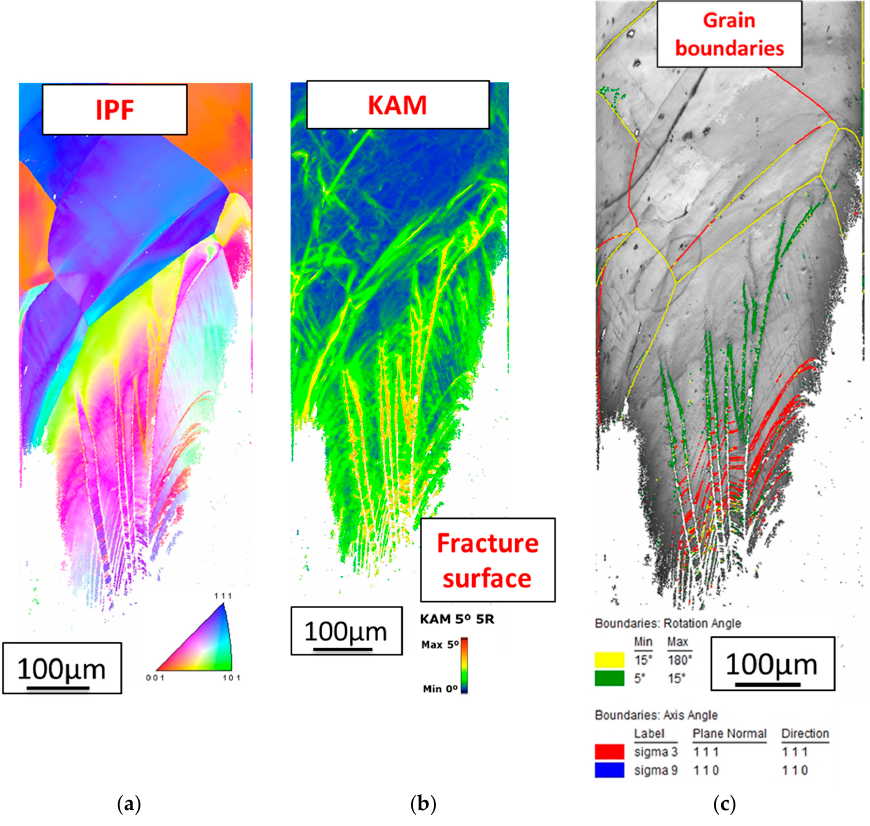
Figure 8. ( a ) Inverse pole figure mapping, ( b ) kernel average misorientation (5°5R) mapping, and ( c ) image quality mapping with grain boundaries of a broken solution annealed oligo-crystalline wire. Metals 2018 , 8 , x FOR PEER REVIEW